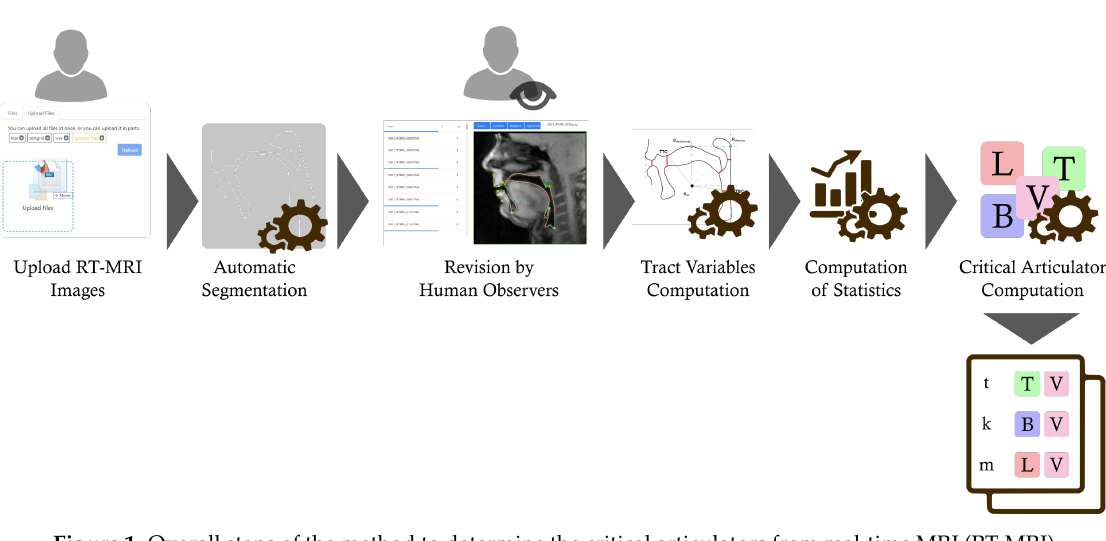
Figure 1. Overall steps of the method to determine the critical articulators from real-time MRI (RT-MRI) images of the vocal tract. After MRI acquisition and audio annotation, the data is uploaded to our speech studies platform, under development [35], and its processing and analysis are carried out resulting in a list of critical tract variables per phone. Refer to the text for additional